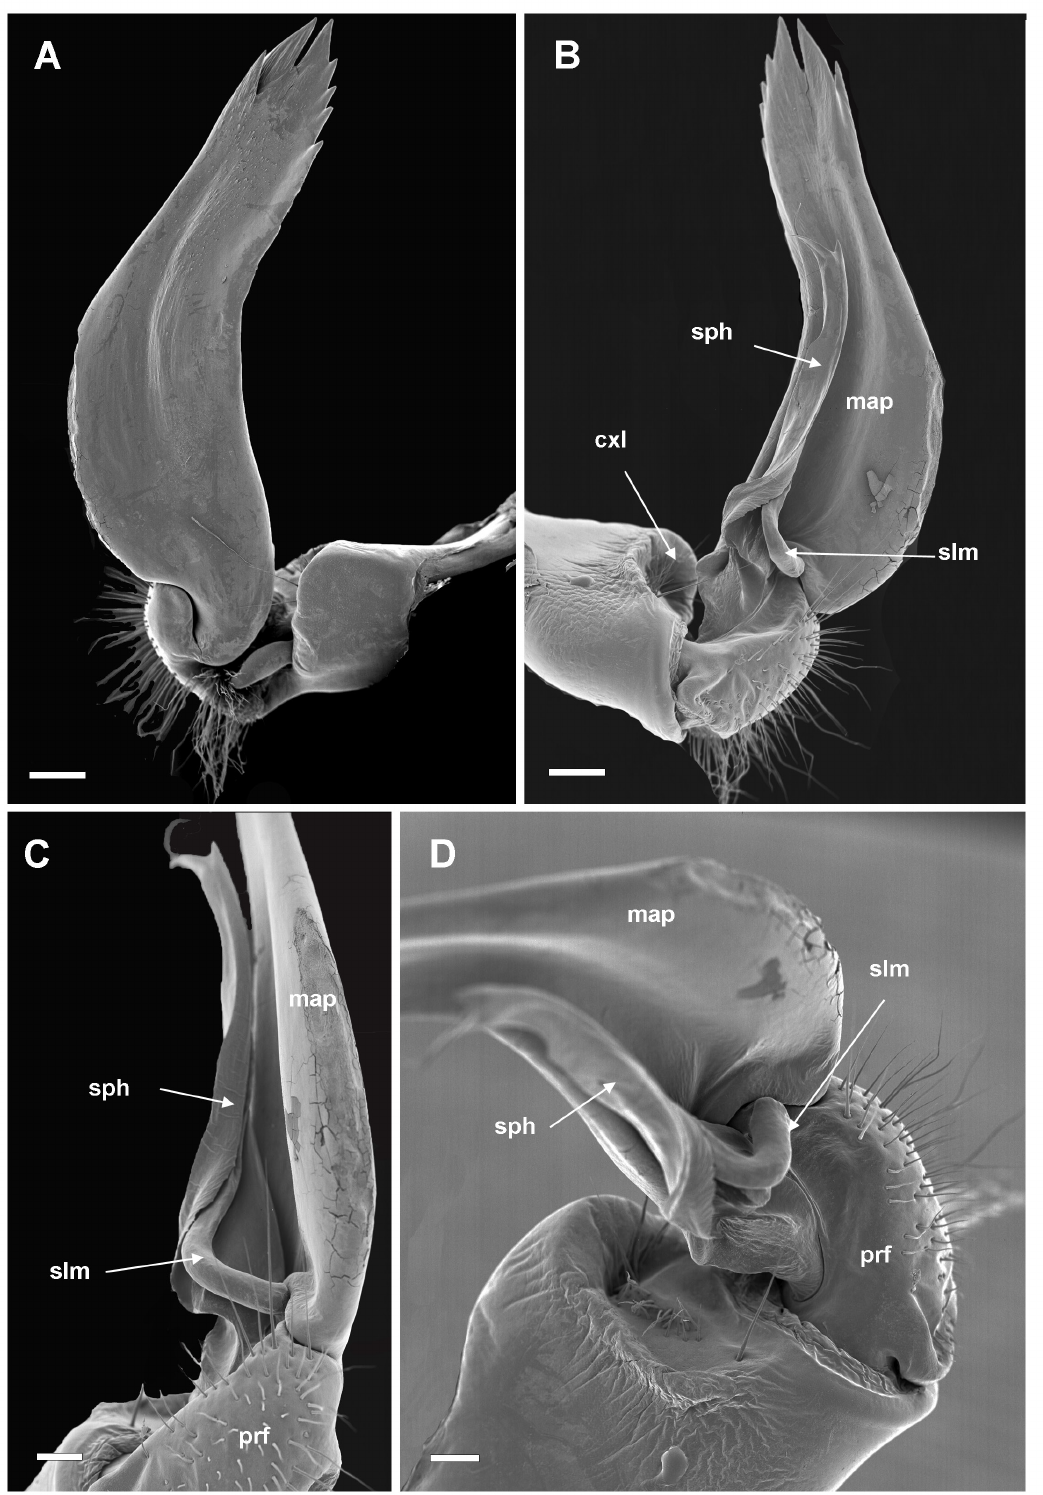
Fig. 25. Eviulisoma grumslingslak sp. nov., paratype, right gonopod. A . Mesal view. B . Lateral view. C . Ventral view. D . Lateral view, detail, showing coxal lobe and entrance of solenomere into solenophore. Abbreviations: cxl = coxal lobe; map = mesal acropodital process; prf = prefemur; slm = solenomere; sph = solenophore.Scale bars: A–B = 0.2 mm; C–D = 0.1